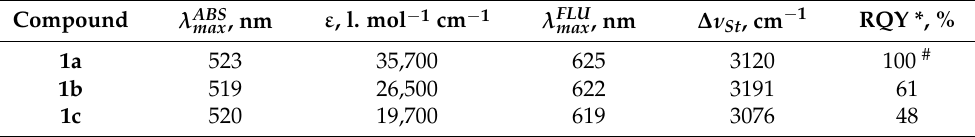
Table 1. Photophysical characteristics of the investigated compounds in mixed DCM/MeOH (1:1) solvent. Compound λ ABS max , nm 523 35,700 625 3120 100 # 519 26,500 3191